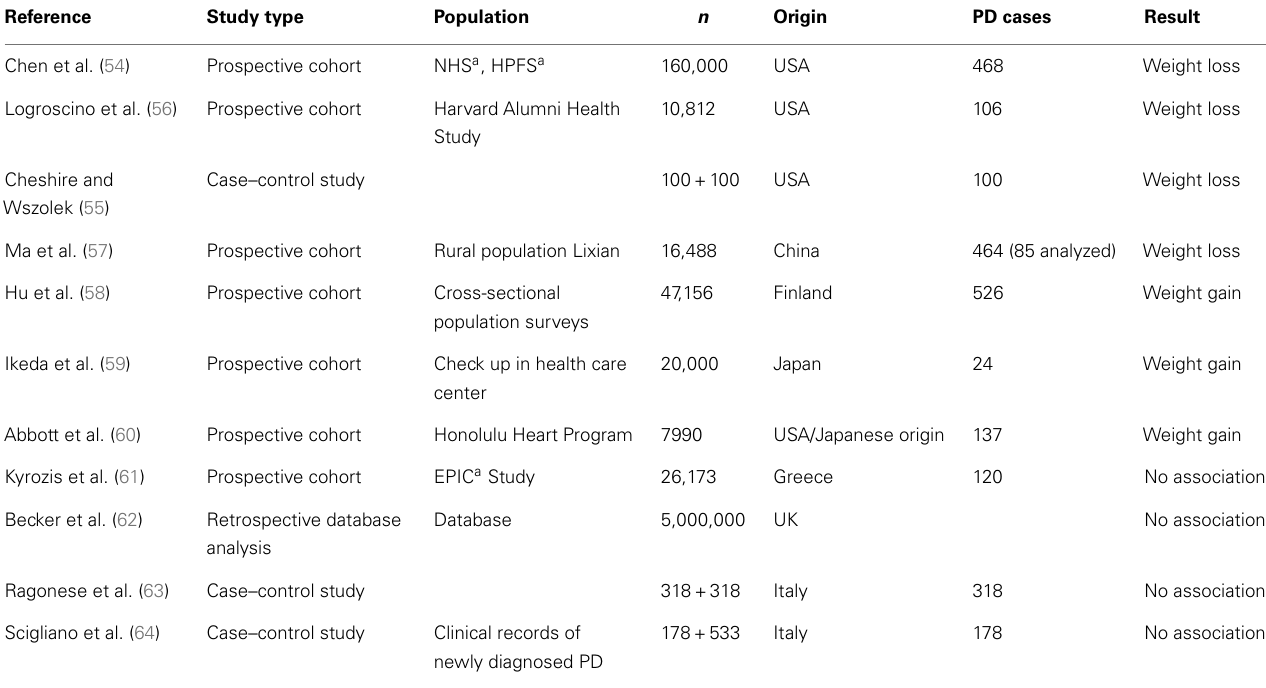
Table 1 | Body weight modification in pre-motor PD